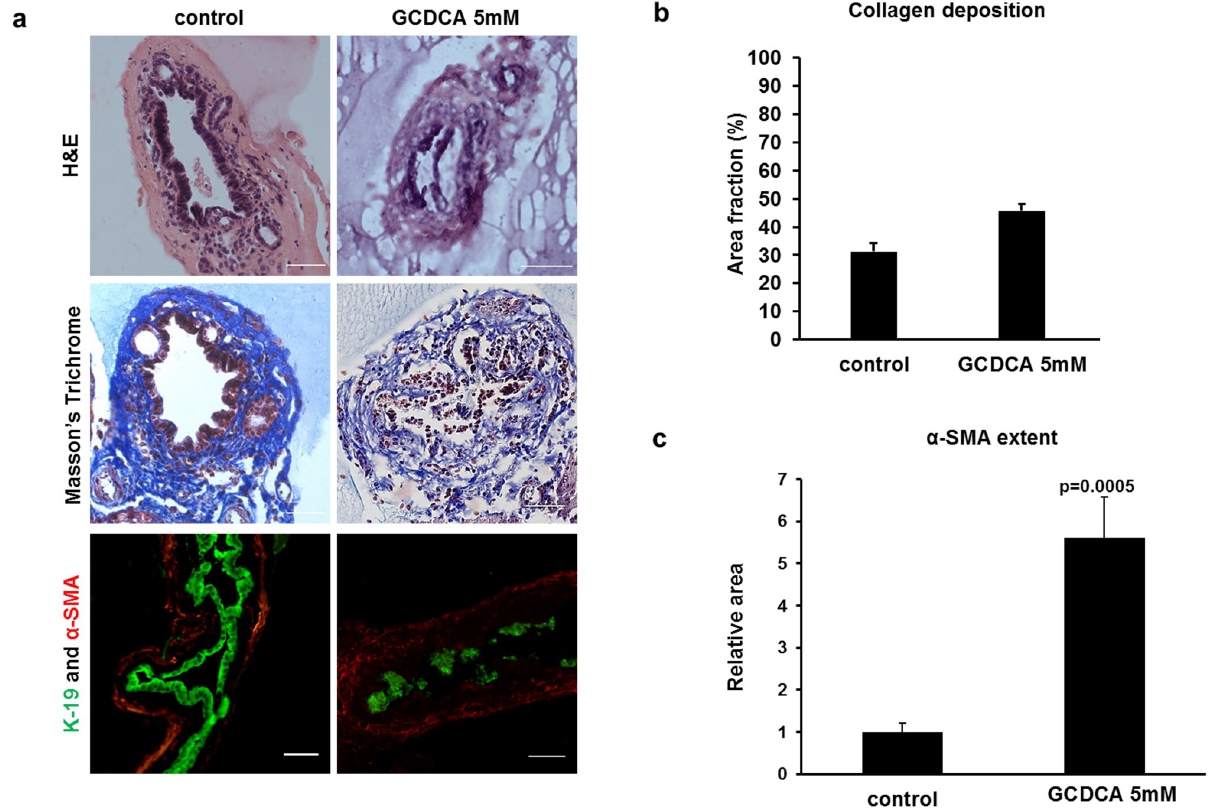
Fig 1. Glycochenodexycholic acid (GCDCA) causes cholangiocyte injury and subepithelial fibrosis in mice extrahepatic bile ducts (EHBDs). (a) EHBDs were dissected and incubated for 24 hours with and without GCDCA at 5mM. The ducts were then sectioned and stained for hematoxylin and eosin (upper panel), Masson’s trichrome (middle panel), and immunofluorescence: the cholangiocyte marker K19 (green) and the myofibroblast marker α -SMA (red) (lower panel). Disruption of the cholangiocyte layer was observed with all three staining modalities. Marked fibrosis was evident, with a thickened collagen layer highlighted with Masson’s trichrome, and with increased immunofluorescent stain with α -SMA. Scale bar, 50 μ m. (b) The extent of collagen deposition was expressed as the proportion (%) of Masson’s trichrome stained area with respect to the total biopsy area (control 31.2% ± 2.93, GCDCA 5mM 44.53% ± 2.23, GCDCA 50mM 71.8% ± 5.13, (n = 18 ducts)). (c) Quantification of the total relative α -SMA positive area in the bile ducts (control 1 ± 0.213 (n = 24), GCDCA 5.6104 ± 0.972, (n = 16)). Data represent mean ± standard error of the mean, N = 4–6 independent